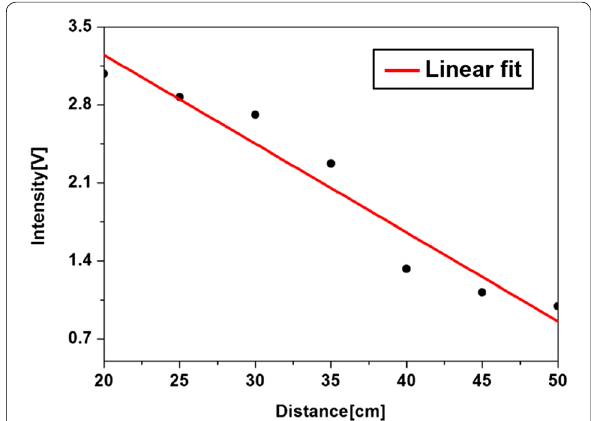
Fig. 9 Measured intensity vs.